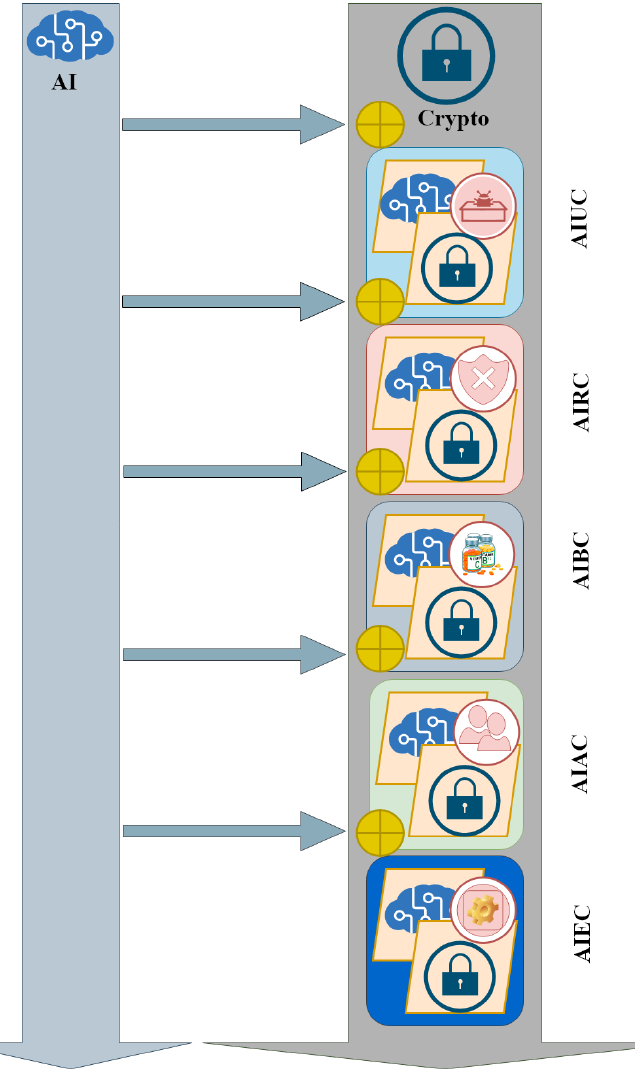
Figure 2. The Evolutionary Path of